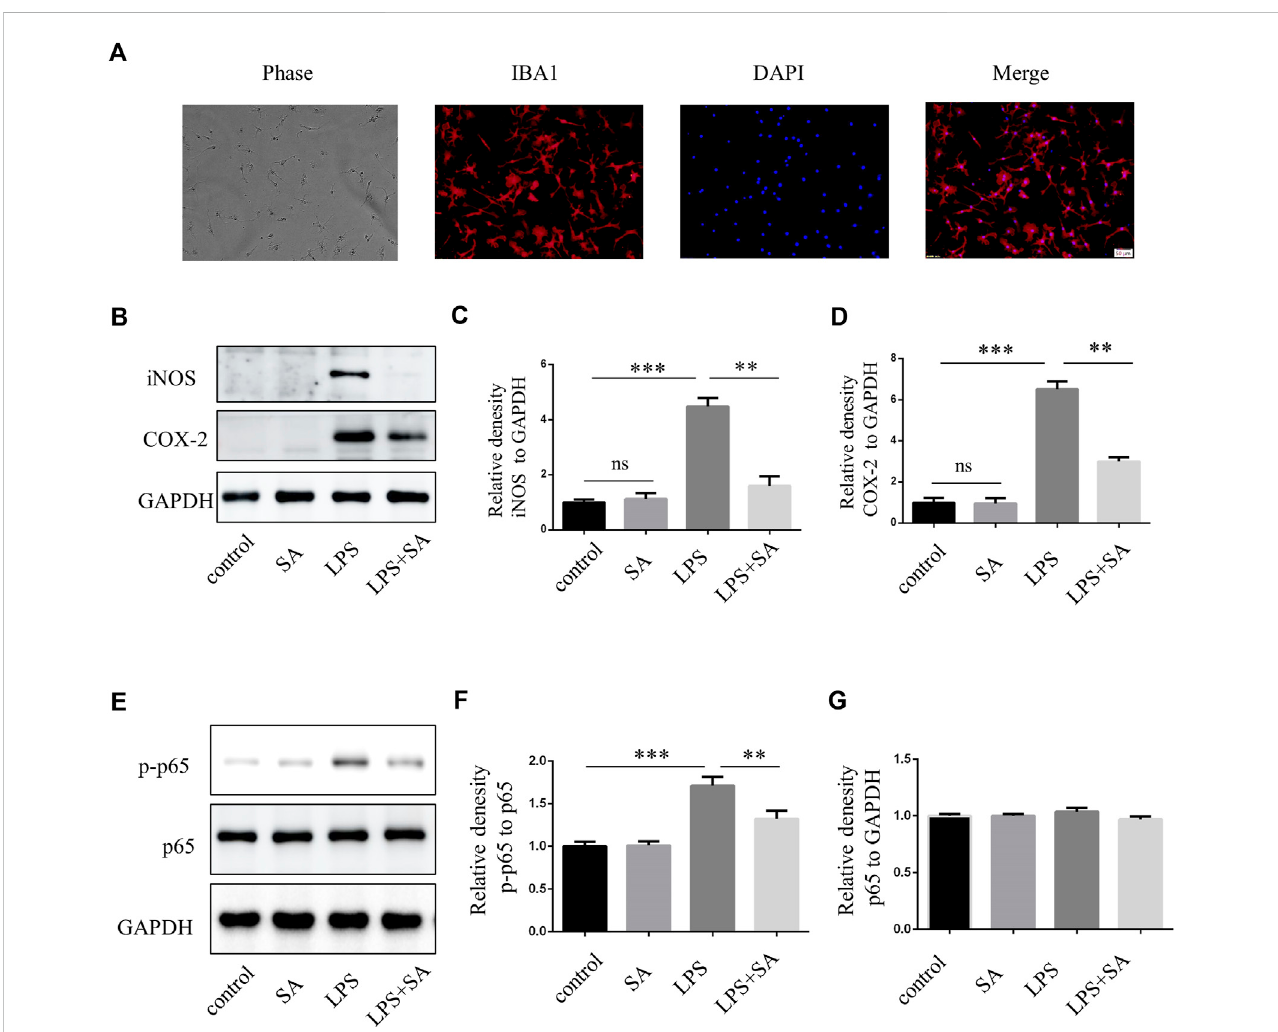
FIGURE 3 SA inhibited LPS-induced activation of primary microglia in vitro . (A) Primary microglia cells were stained with IBA1 antibody. (B – D) BV2 cells were pretreatedwithSA(5 µM)for12 handLPS(100 ng/mL)wasaddedforanother12 h.ProteinswereextractedandtheproteinlevelsofiNOS,COX-2andGAPDH were measured by western blot assay. (E – G) Primary microglia were pretreated with SA for 12 h. After adding LPS (100 ng/mL) for 15 min, the protein was extracted andthe proteinlevels of p65, p-p65 weredetected by western blotassay. Date are presented as mean ± SD,** p < 0.01,*** p < 0.001, n =3per group. Scale bar, 50